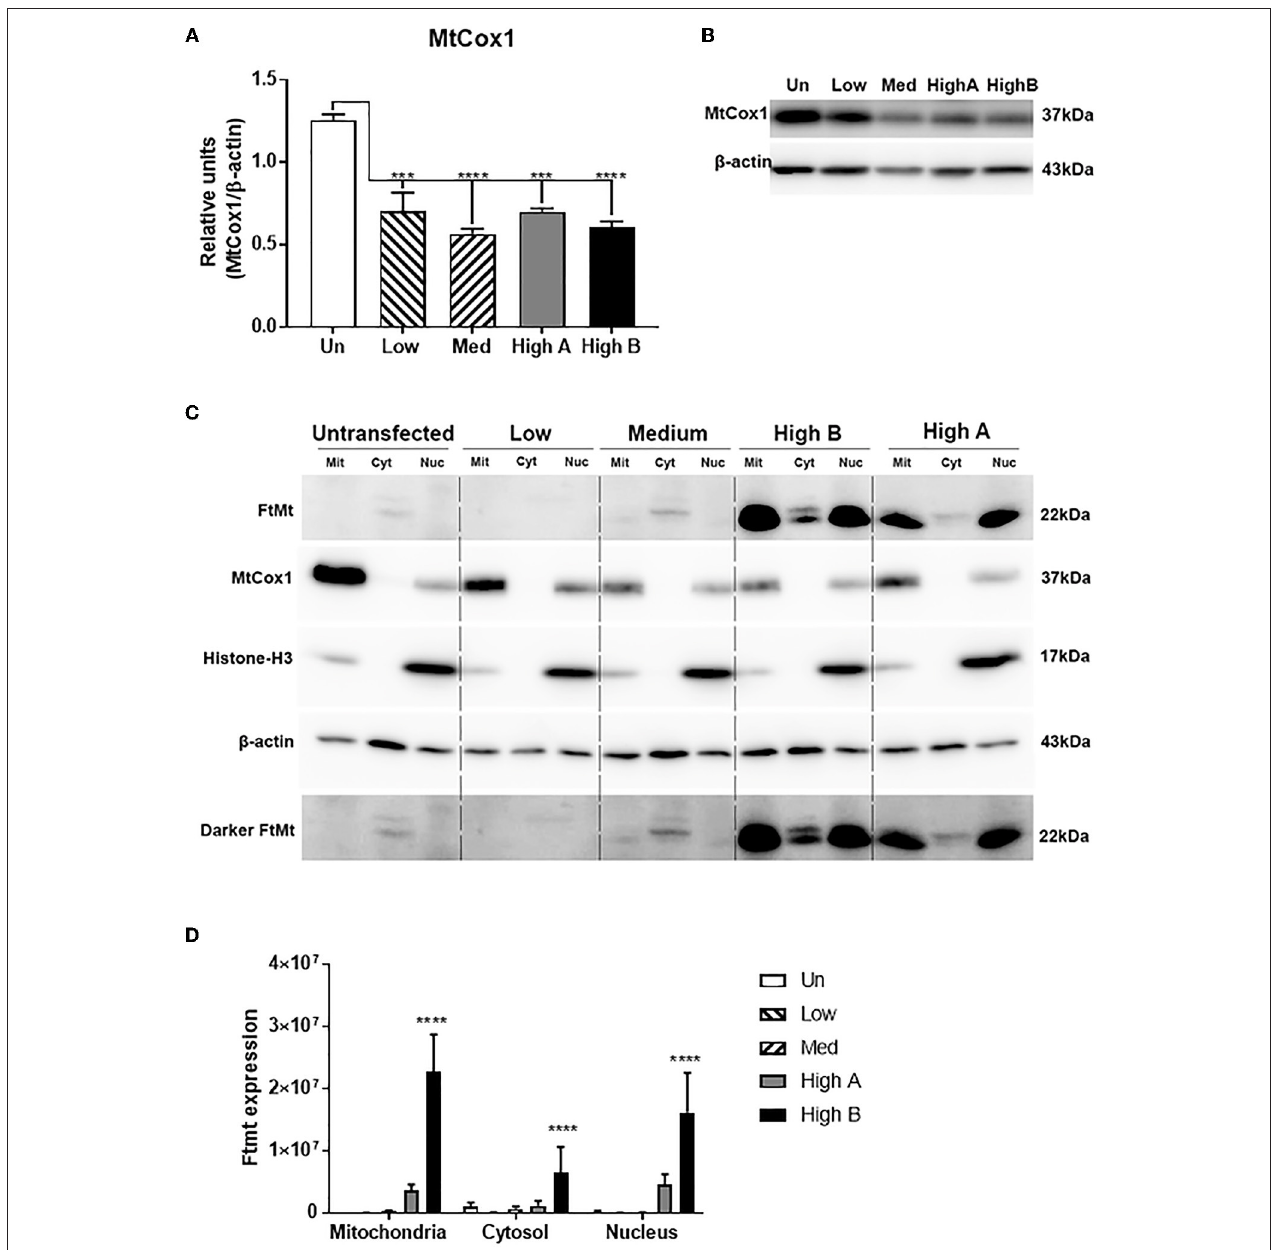
FIGURE 3 | Characterization of mitochondria in FtMt expressing clones. (A,B) Western blot measurements of MtCox-1 in whole cell extracts. Measurement of Mt Cox-1 in total cell lysates by western blots gave the reverse result compared to immunocytochemistry. There were significantly reduced levels of MtCox-1 protein in FtMt expressing clones. Results based on triplicate determinations. The different patterns of expression are shown in representative western blot. (C) Composite western blot panel of subcellular fractions from FtMt expressing clones. Cell extracts from differentiated clones fractionated into mitochondria (Mit), cytosol (Cyt), and nucleus (Nuc) fractions were analyzed by western blot and probed with antibodies to FtMt, MtCox1, Histone -H3, and β -actin. The results for MtCox1 and Histone-H3 indicate that the mitochondria contain some contaminating nuclei, and the nuclei contain some contaminating mitochondria. The results show that the majority of overexpressed FtMt is present in mitochondria though the abundance in nucleus is higher than might be expected from mitochondria contamination. Enhanced exposure was needed to demonstrate FtMt in Med clone (Darker Ftmt). A non-specific band of higher molecular weight than FtMt. is detected in cytosol fraction. (D) Quantitative estimation of results in (A) . Results show relative levels of FtMt protein in different fractions from FtMt expressing clones. Results are not normalized and represent signal intensities from triplicate experiments. Results show mean ± SEM, with standard significance levels indicated from data analyzed by one way ANOVA with Tukey’s post-hoc test. *** p < 0.001, **** p < 0.0001.